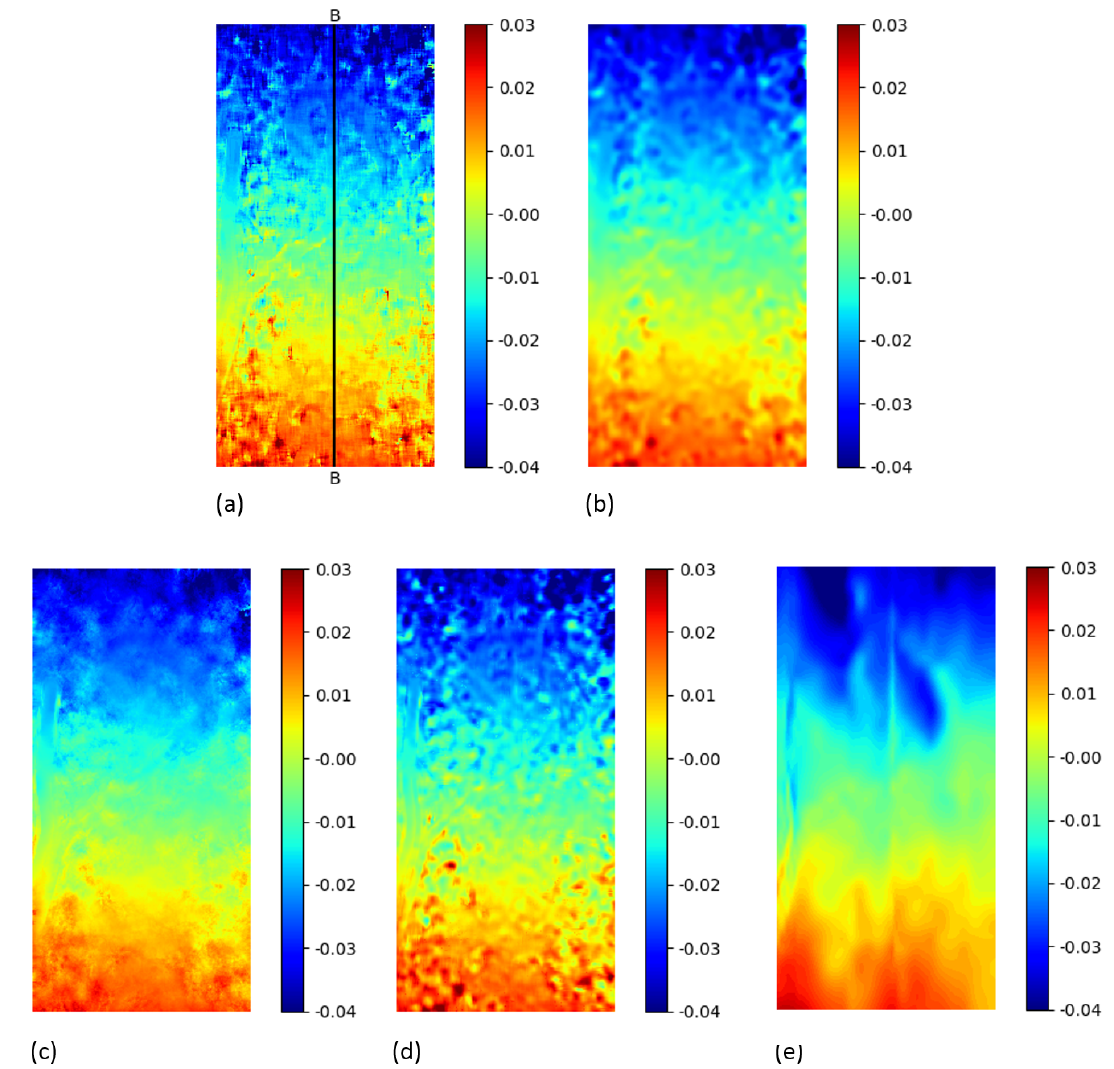
Figure 10. u displacements (mm) for the tensile test of GFRP sample obtained from DIC technique. ( a ) py2DIC raw results ( b ) py2DIC smoothed results using Gaussian filter ( c ) Ncorr results ( d ) Vic-2D results ( e ) DICe results